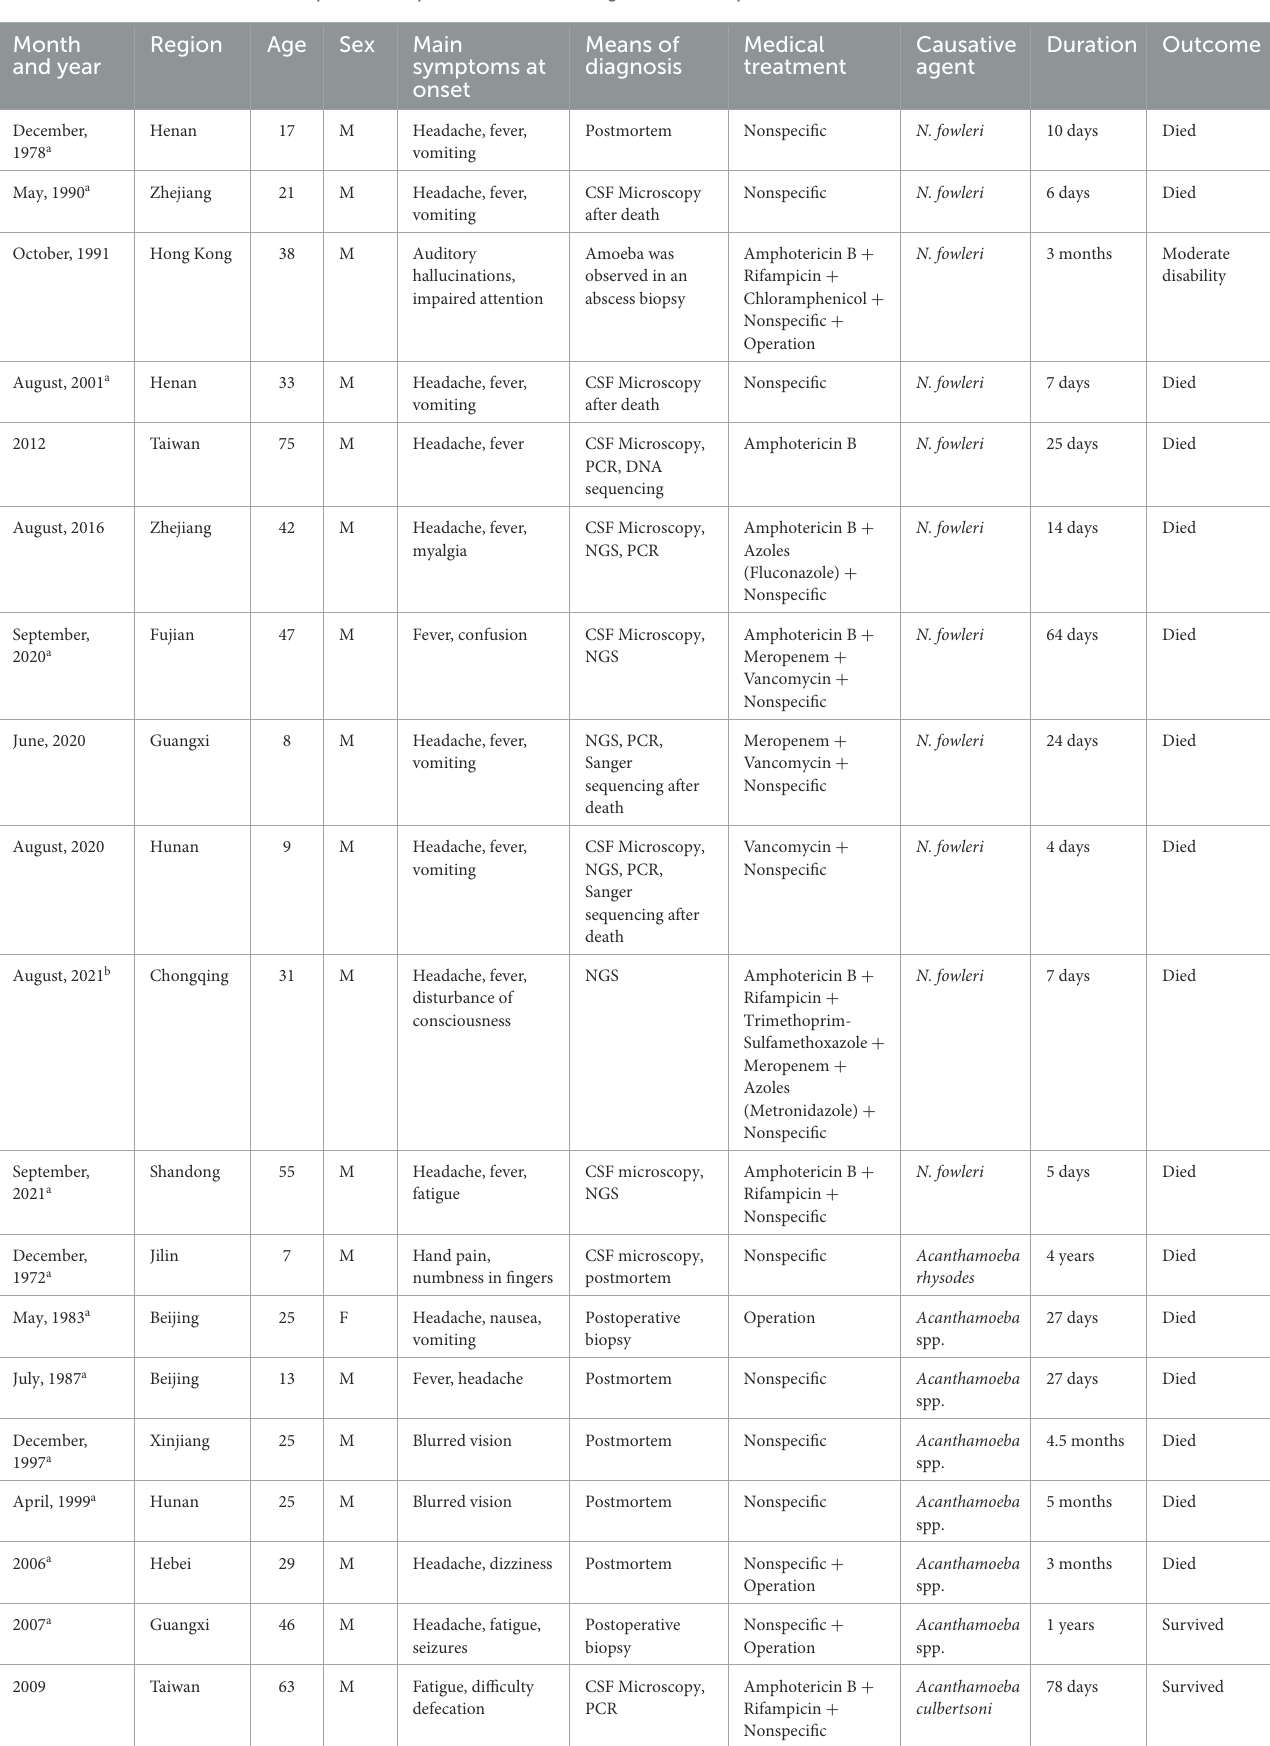
TABLE 1 The clinical characteristics of published reports of three free-living amoebic encephalitis. Month and